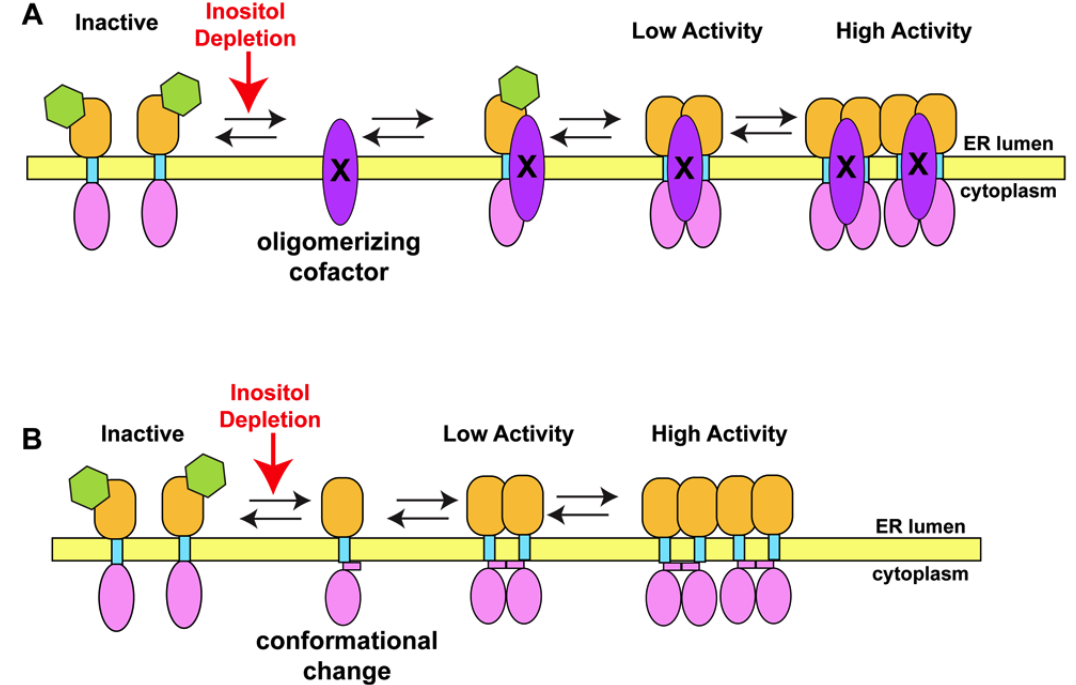
Figure 3. Alternative Ire1p activation Models. ( A ) Co-factor model. Upon inositol depletion, a membrane-associated or integral membrane protein accumulates in the